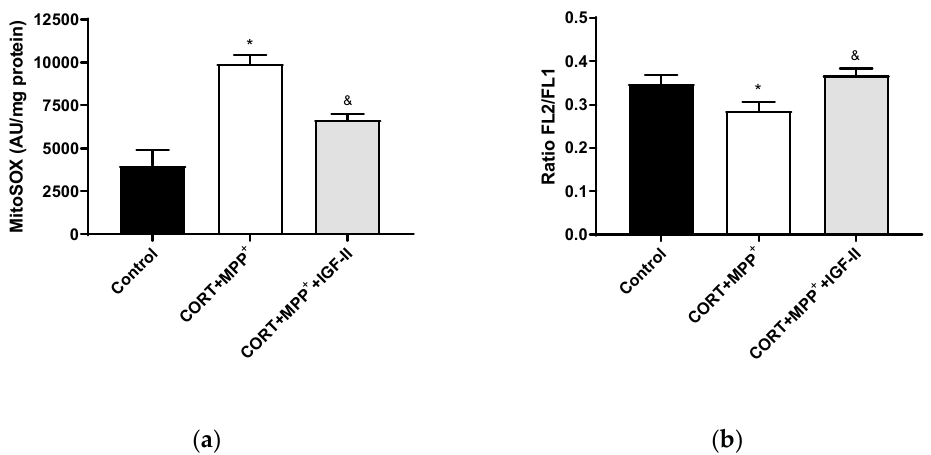
Figure 3. Mitochondrial markers in SN4741 neuronal cells after 2.5 h of incubation with the combi- nation of corticosterone and MPP + (CORT + MPP + ) in the presence or absence of IGF-II. ( a ) Mito- chondrial levels of ROS; ( b ) cytofluorometric analysis of mitochondrial membrane potential (m ∆Ψ ). Data were combined from three to four independent experiments and presented as mean ± SEM. * p < 0.05 compared to control cells; & p < 0.05 compared with CORT + MPP + co-incubated cells.